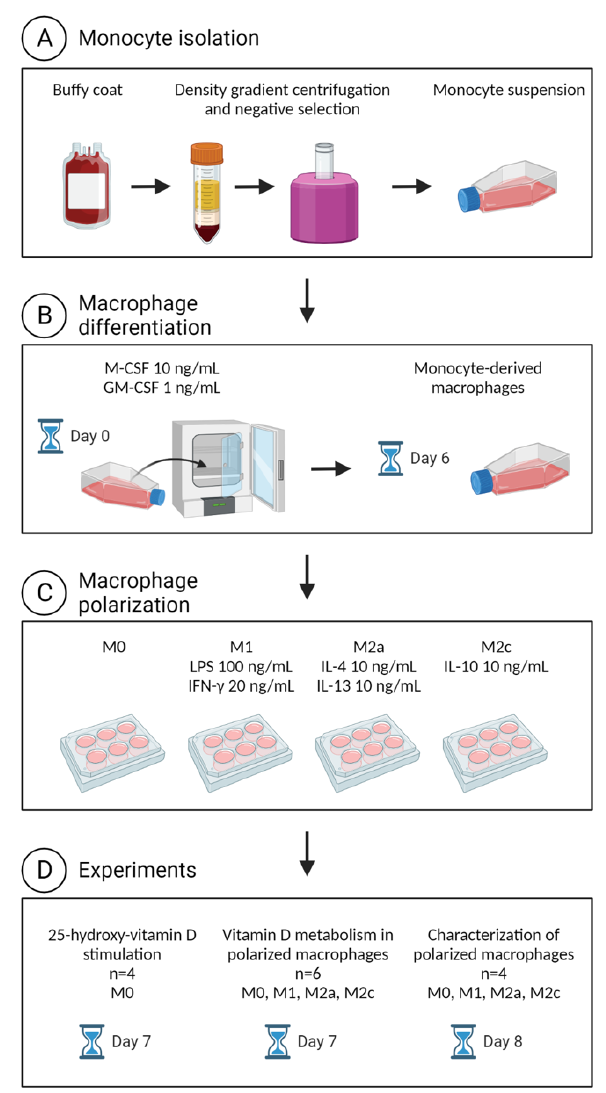
Figure 5. This figure shows the cell isolation and polarization protocol. First, we performed monocyte isolation ( A ), then macrophage differentiation ( B ), then macrophage polarization ( C ) and last the actual experiments ( D ). The figure was created using Biorender.com (accessed on 25 August 2022).